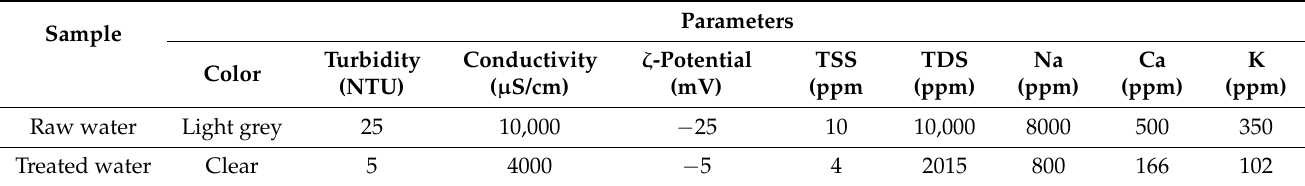
Table 7. Analysis of raw and treated brackish water under the optimized